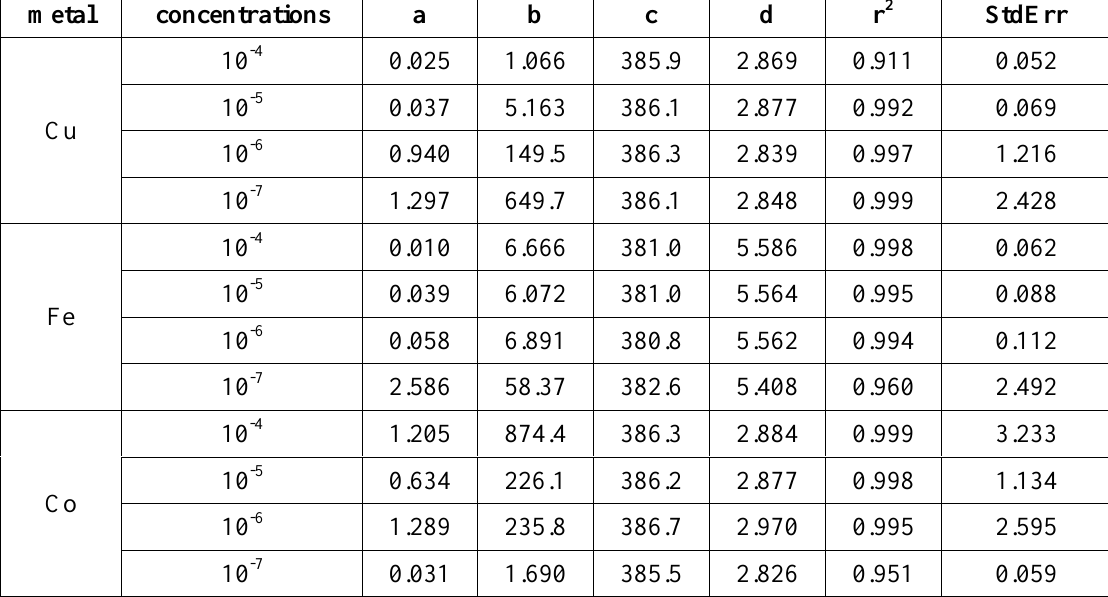
Table 1: Value of equation's coefficients and stander deviation error (StdErr) for Cu +2 , Co +2 and Fe +3 with different